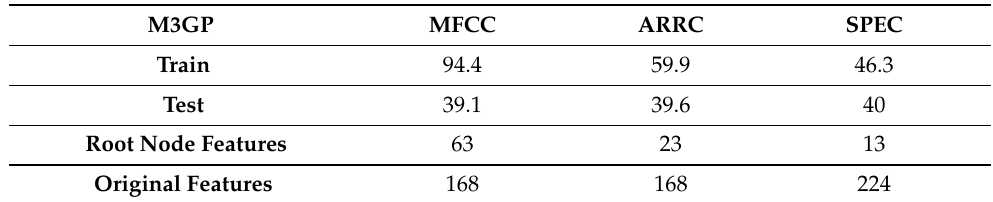
Table 5. The accuracy obtained by M3GP, the number of root node features of the best solution found in each dataset, and the original features of each set.